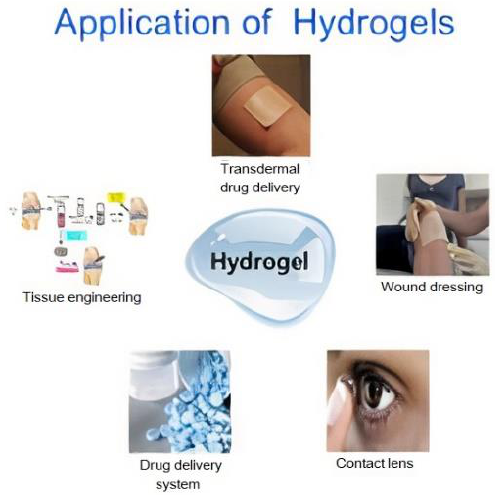
Figure 2. Applications of hydrogel.